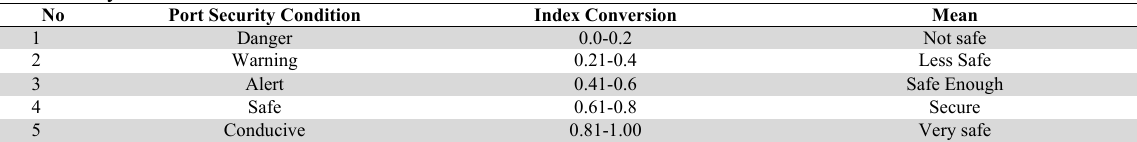
Port Security Index